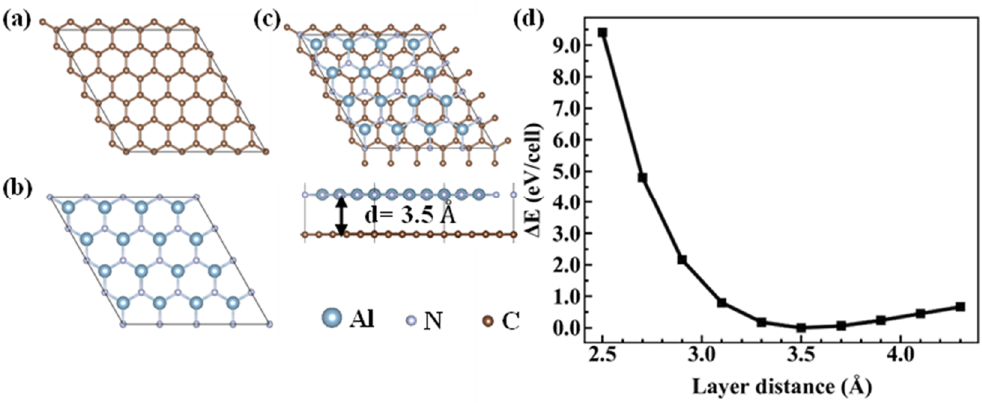
Figure 1. ( a ) The 5 × 5 supercell of graphene, ( b ) the 4 × 4 supercell of AlN, ( c ) the top view (upper) and side view (lower) of graphene/AlN heterojunction. ( d ) The energy difference with respect to the most stable structure of the graphene/AlN system as a function of interlayer distance.